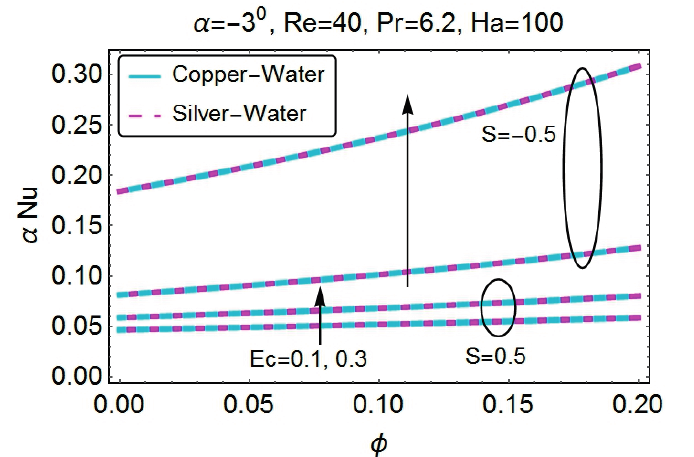
Figure 35. Variation in the Nusselt number with the Eckert number and the nanoparticle volume fraction (convergent